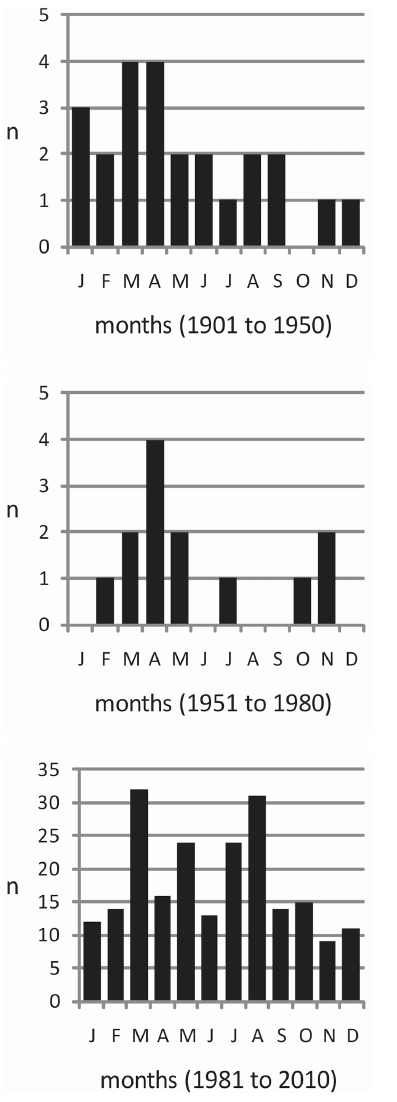
Fig. 5. (a–c) Monthly distribution of rockfalls in the periods 1901– 1950, 1951–1980 and 1981–2010.